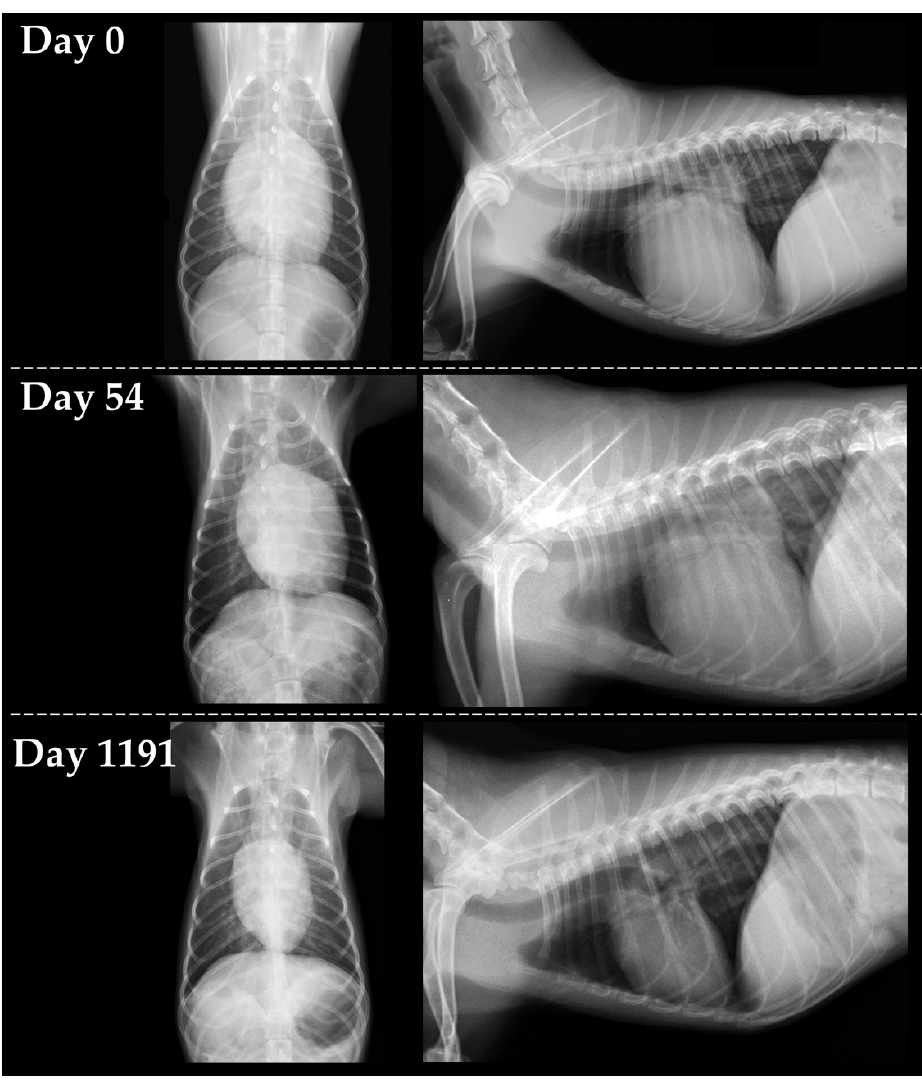
Figure 1. Changes in transthoracic radiography on day 0, day 54 and day 1191. Left figures represent the dorsoventral views, and right figures represent right lateral views. Table 1. Changes in conventional 2D and Doppler examinations on day 0 and day 1191.